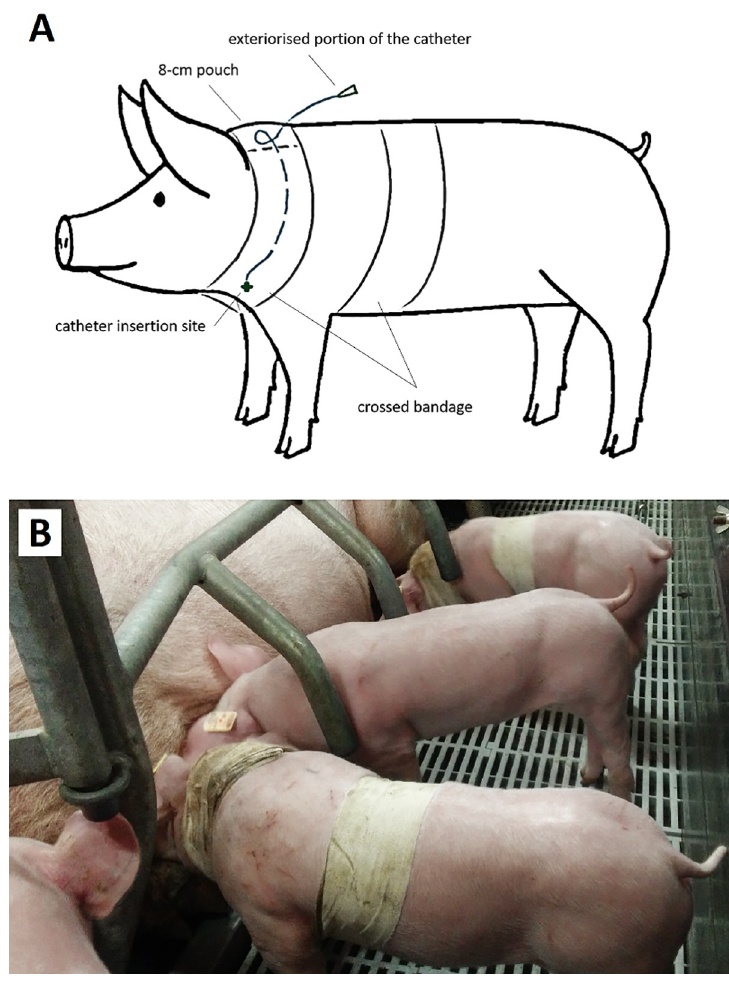
Fig 3. A. Schematic view of catheter positioning in 21-day-old piglets at the end of the catheterization procedure. B. Photograph that shows piglets equipped with catheter during the suckling period. The catheter was covered with a crossed bandage around piglet’s neck and abdomen to ensure overall protection of catheter insertion site. The catheter was routed between two layers of bandage and the exteriorised portion of catheter was placed in a 8 × 8-cm pouch on the dorsal surface of the neck. Piglets were group-housed for 7 days after the surgical